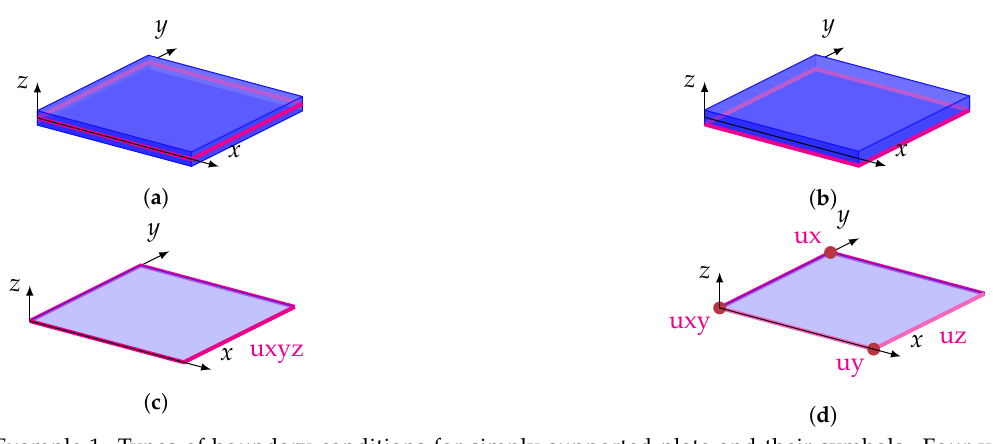
Figure 3. Example 1: Types of boundary conditions for simply supported plate and their symbols. Four versions of boundary conditions: [mh], [ms], [bh], and [bs]. ( a ) boundary condition in the middle of the plate thickness [m{h,s}]; ( b ) boundary condition at the bottom of the plate thickness [b{h,s}]; ( c ) hard simply supported [{m,b}h]; ( d ) soft simply supported